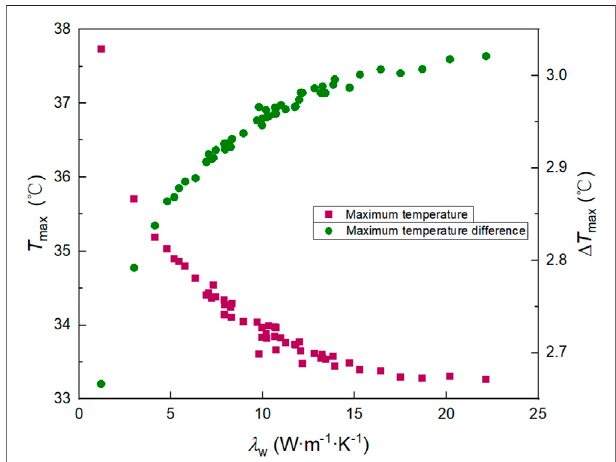
FIGURE 12 | In fl uence of λ w on battery maximum temperature and battery maximum temperature difference.